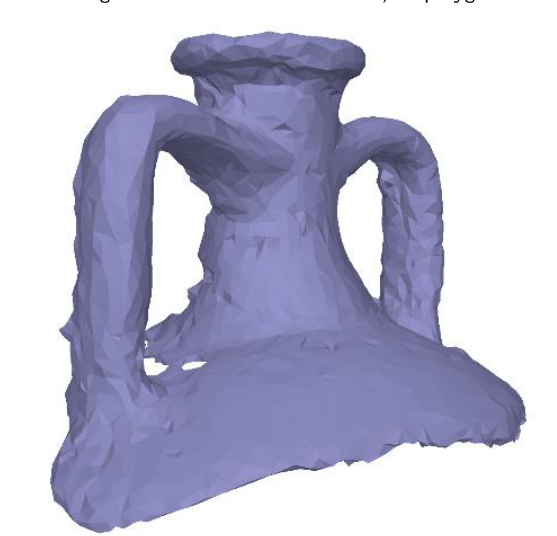
Figure 4. Mesh decimation – 10,000